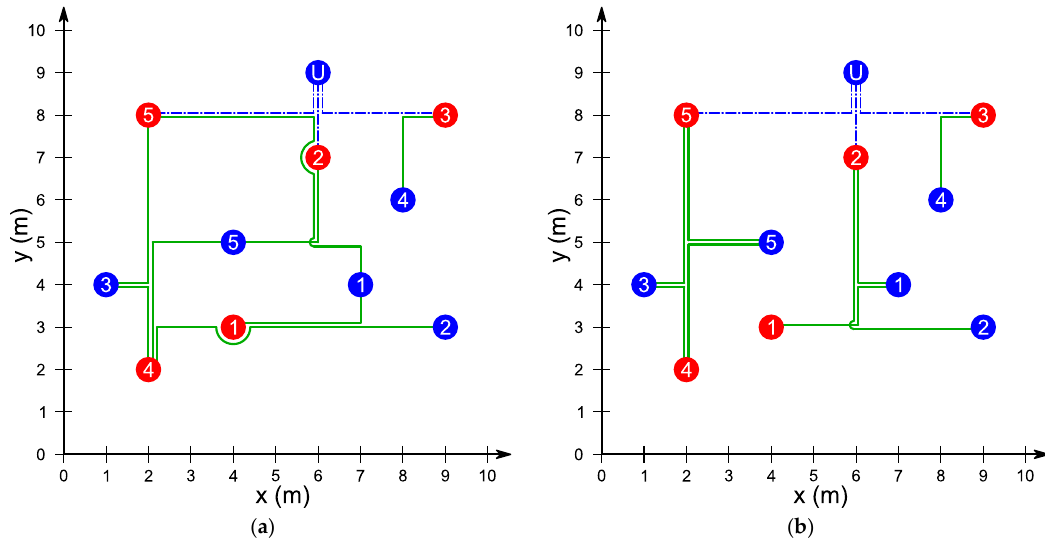
Figure 5. ( a ) 2D layout representation of the optimal HEN configuration of example 1b; ( b ) 2D layout representation of the alternative HEN configuration of example 1b.